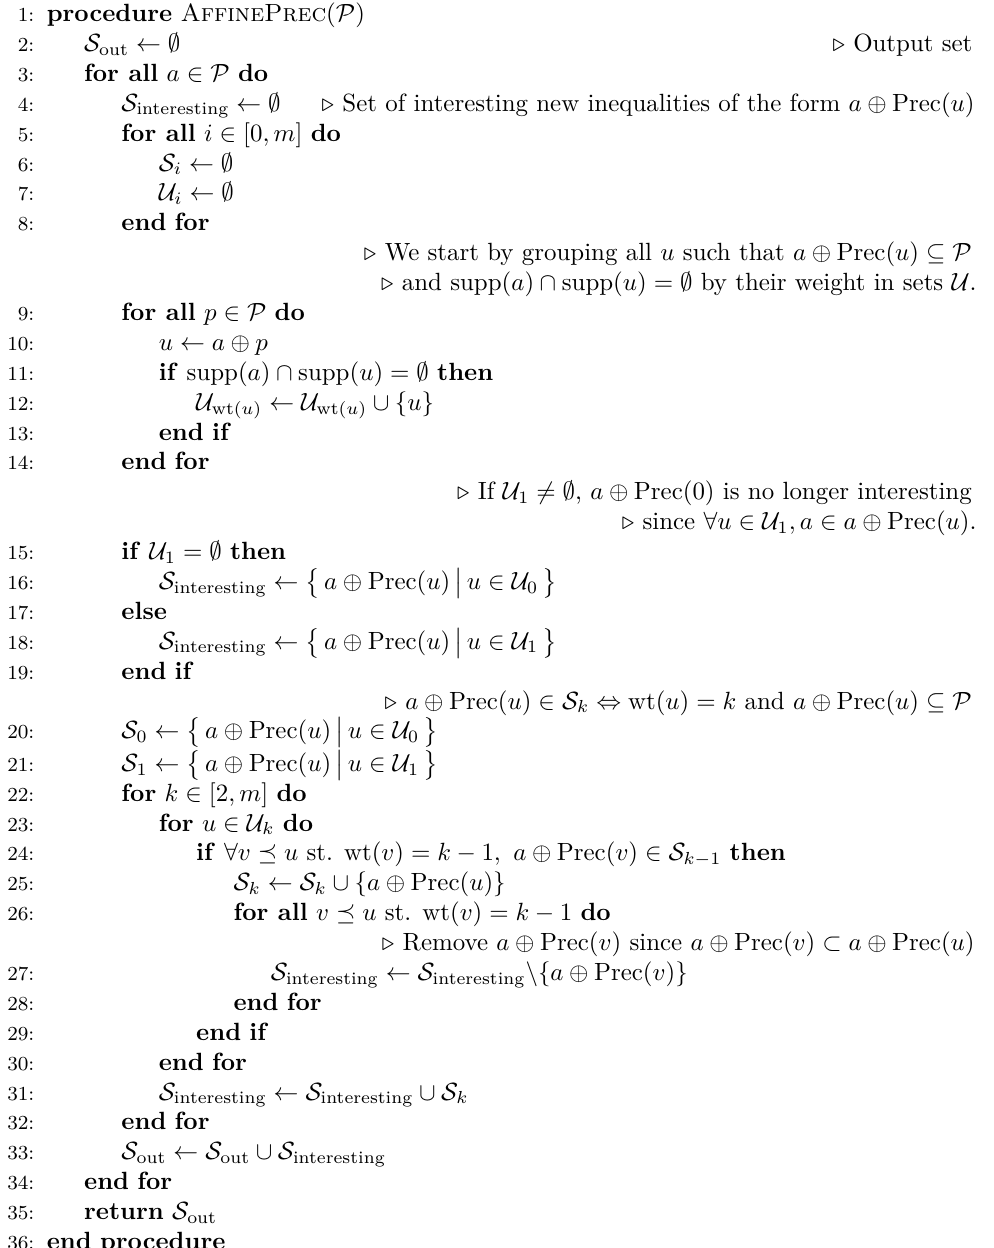
Algorithm 2 Find a ⊕ Prec( u ) sets included in the set P ⊂ { 0 , 1 } m